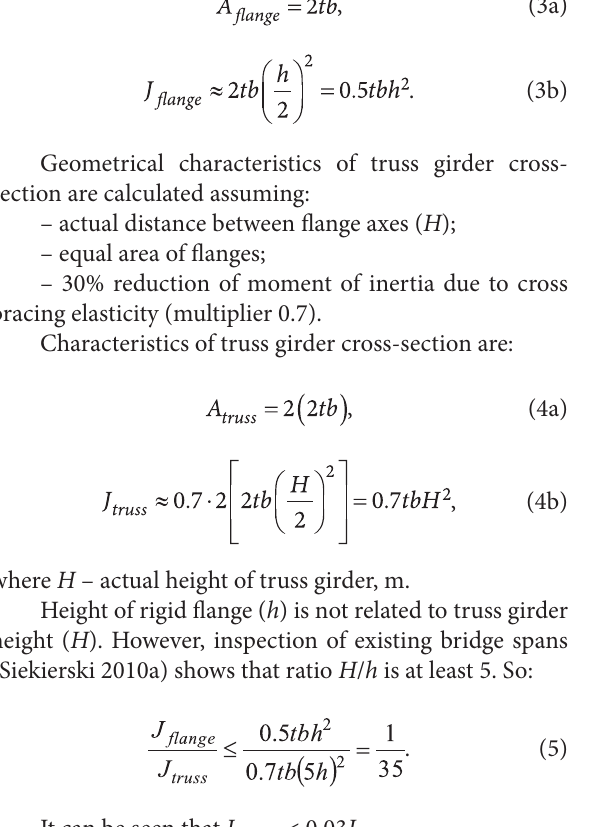
Fig. 5. Assumed cross section of rigid